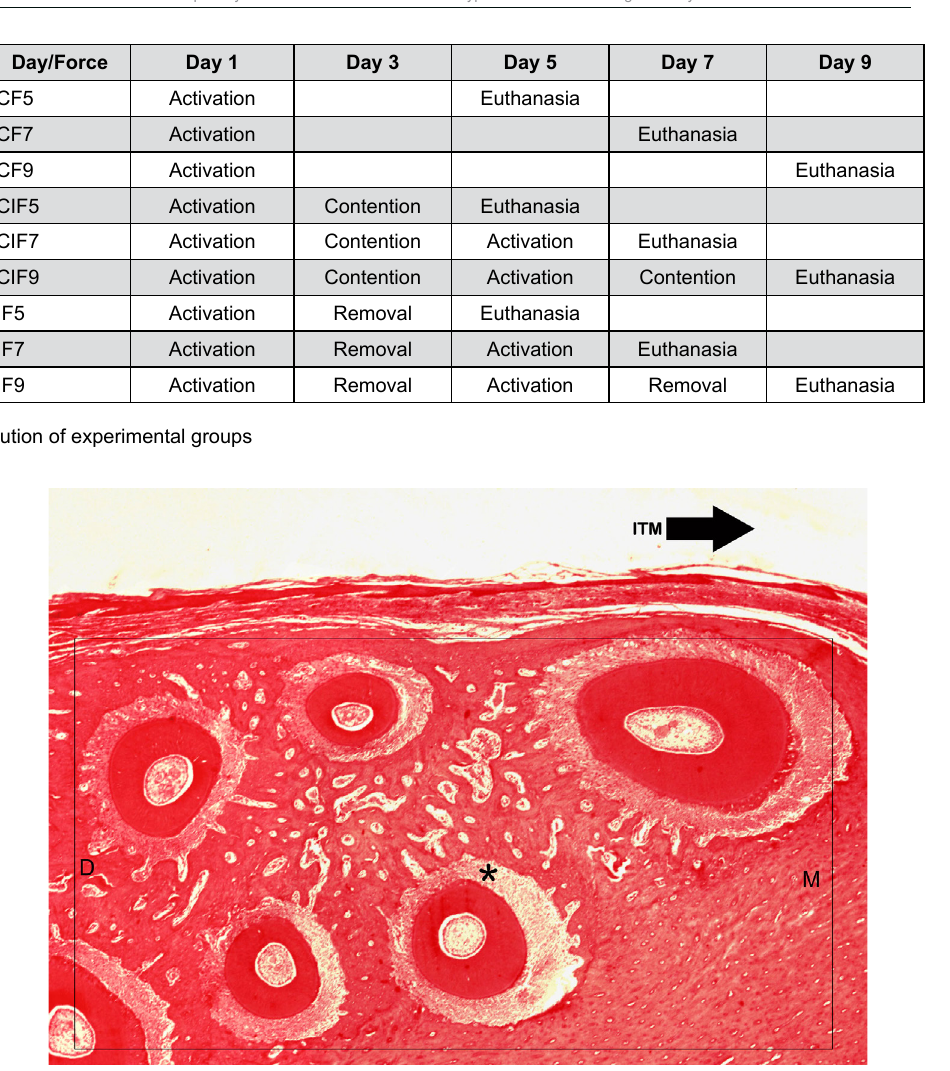
Figure 3- Light micrograph showing the roots of the right maxillary first molar tooth which was submitted to ITM. In black arrow the direction of ITM, in (*) the mesiopalatal root, in (M) mesial and in (D) distal side. Hematoxylin and eosin magnified